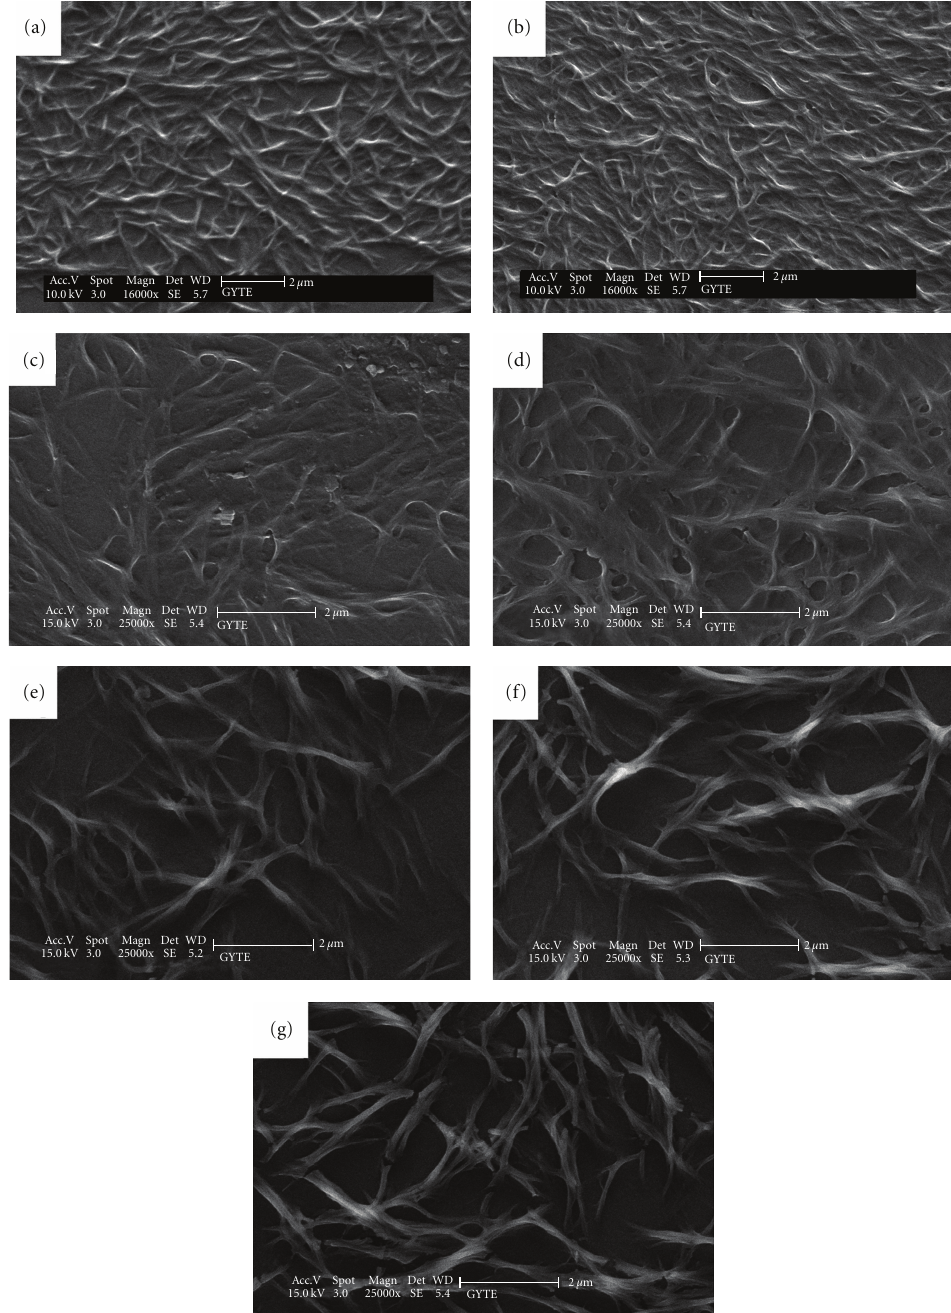
Figure 3: SEM pictures of pure (a), 0.5% (b), 1.5% (c), 3.5% (d), 8.5% (e), 15% (f), and 25% (g) doped TiO 2